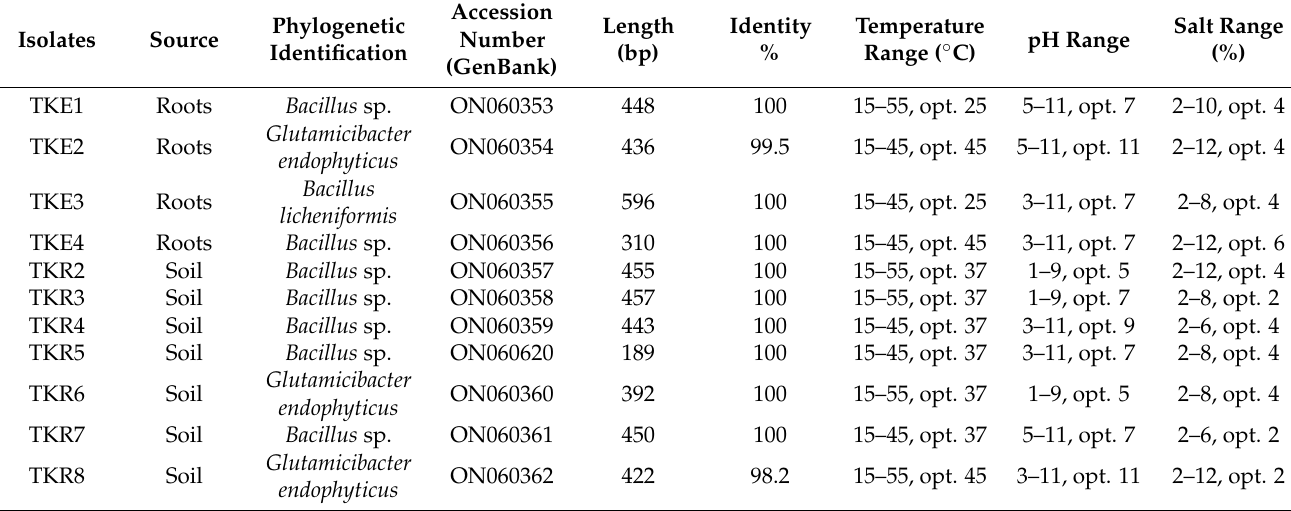
Table 1. Phylogenetic identification and growth parameter analysis of the